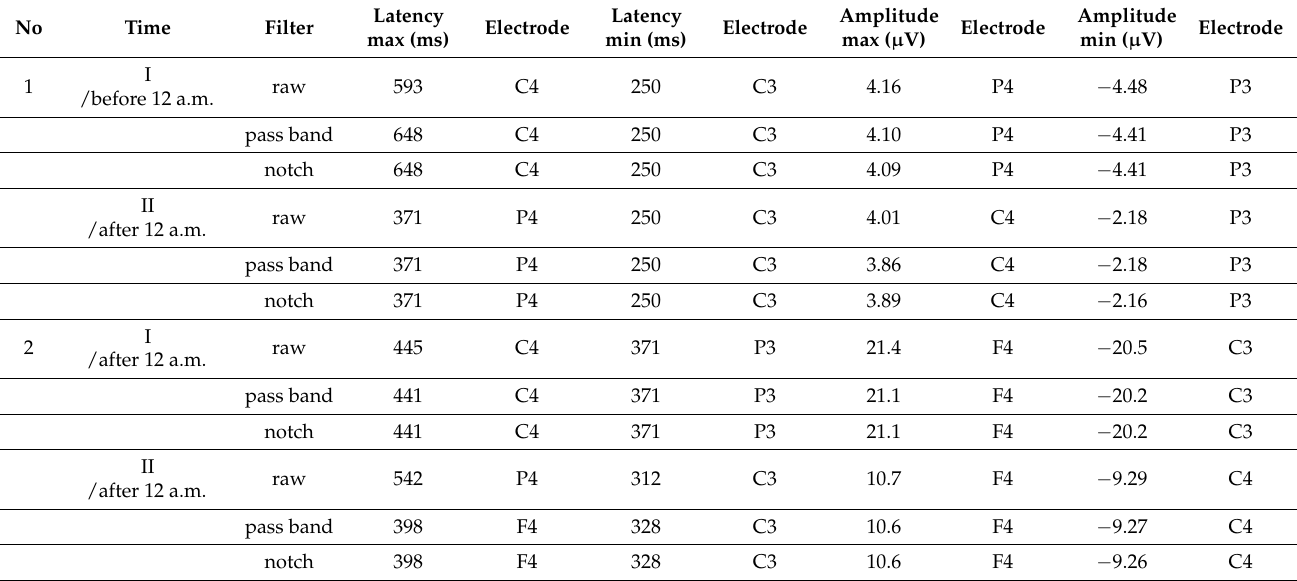
Table 1. Latency values for seven subjects, for selected electrodes (C3, C4, P3, P4, F3,